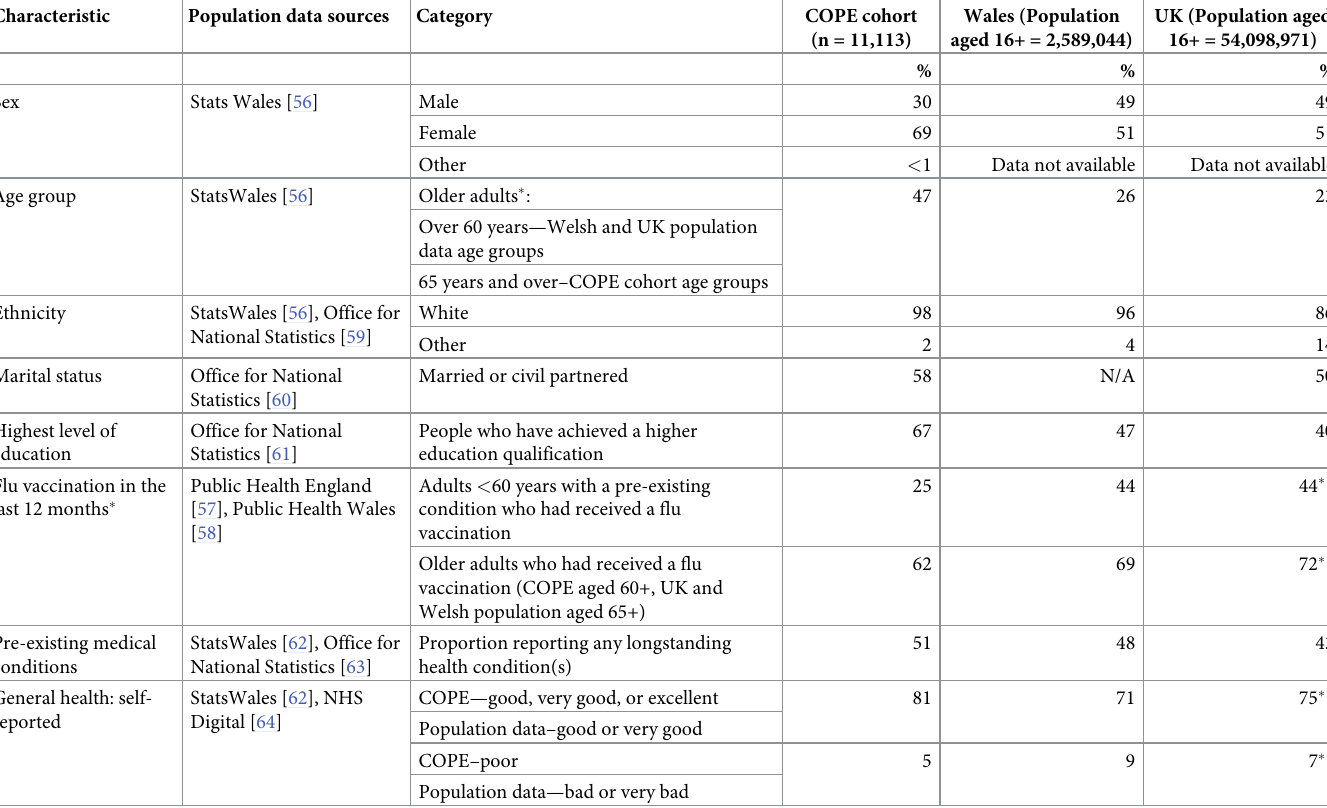
Table 2. COPE cohort baseline characteristics and population data for published sources for Wales and the